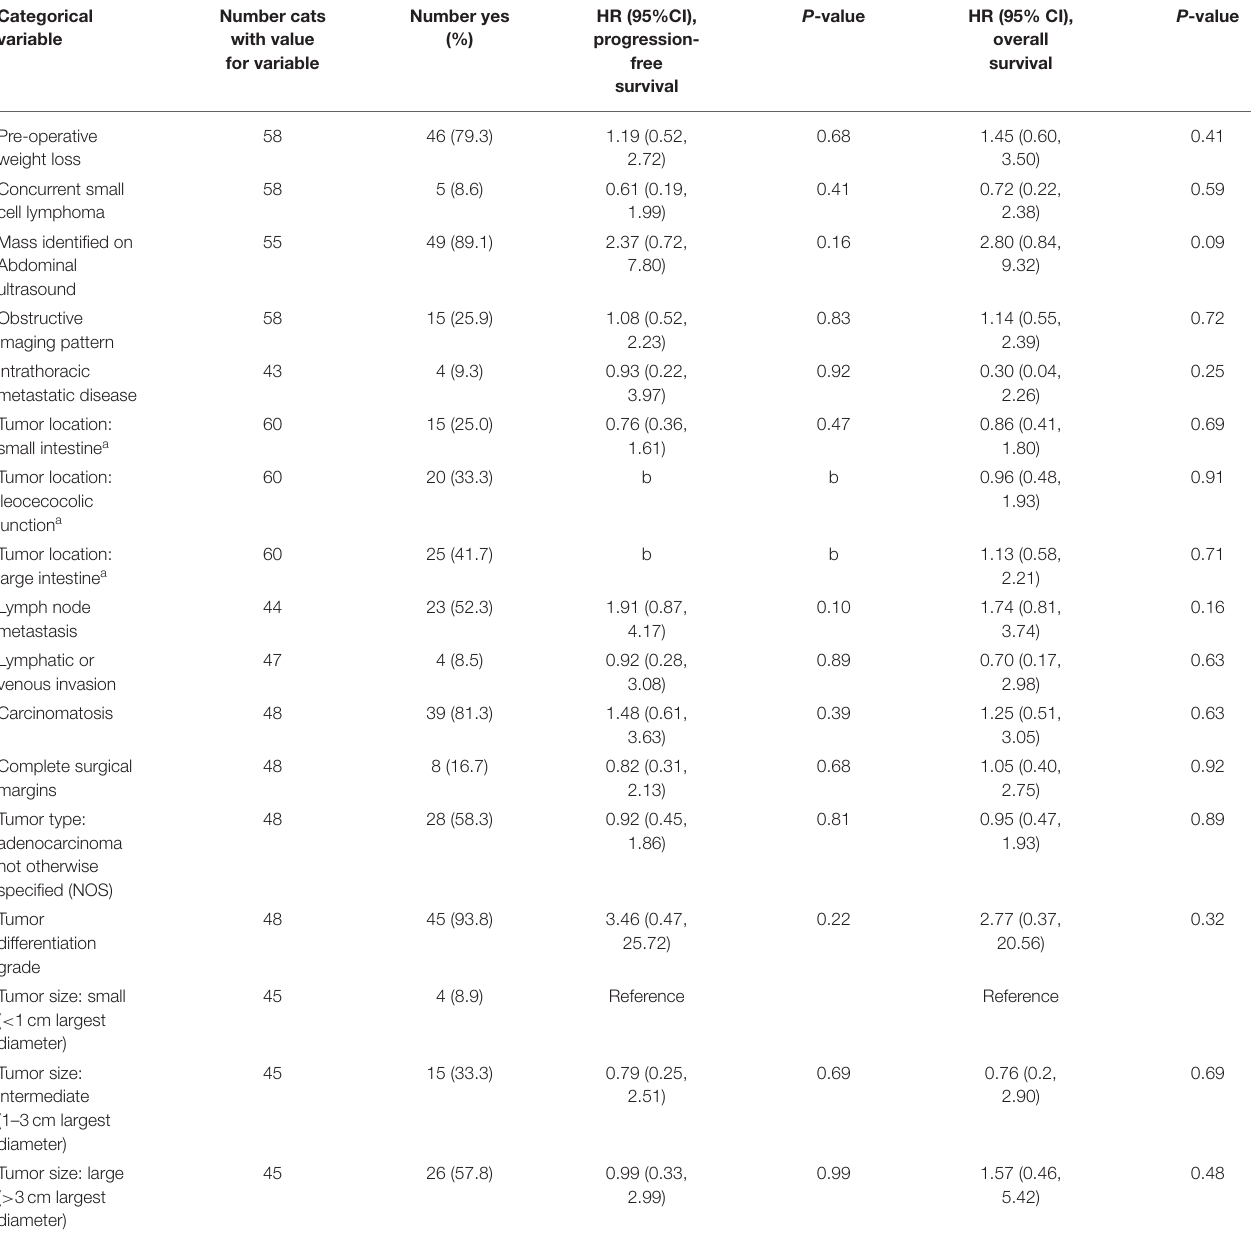
TABLE 1 | Descriptive statistics and results of cox proportional hazards regression for progression-free and overall survival associated with categorical variables. Categorical